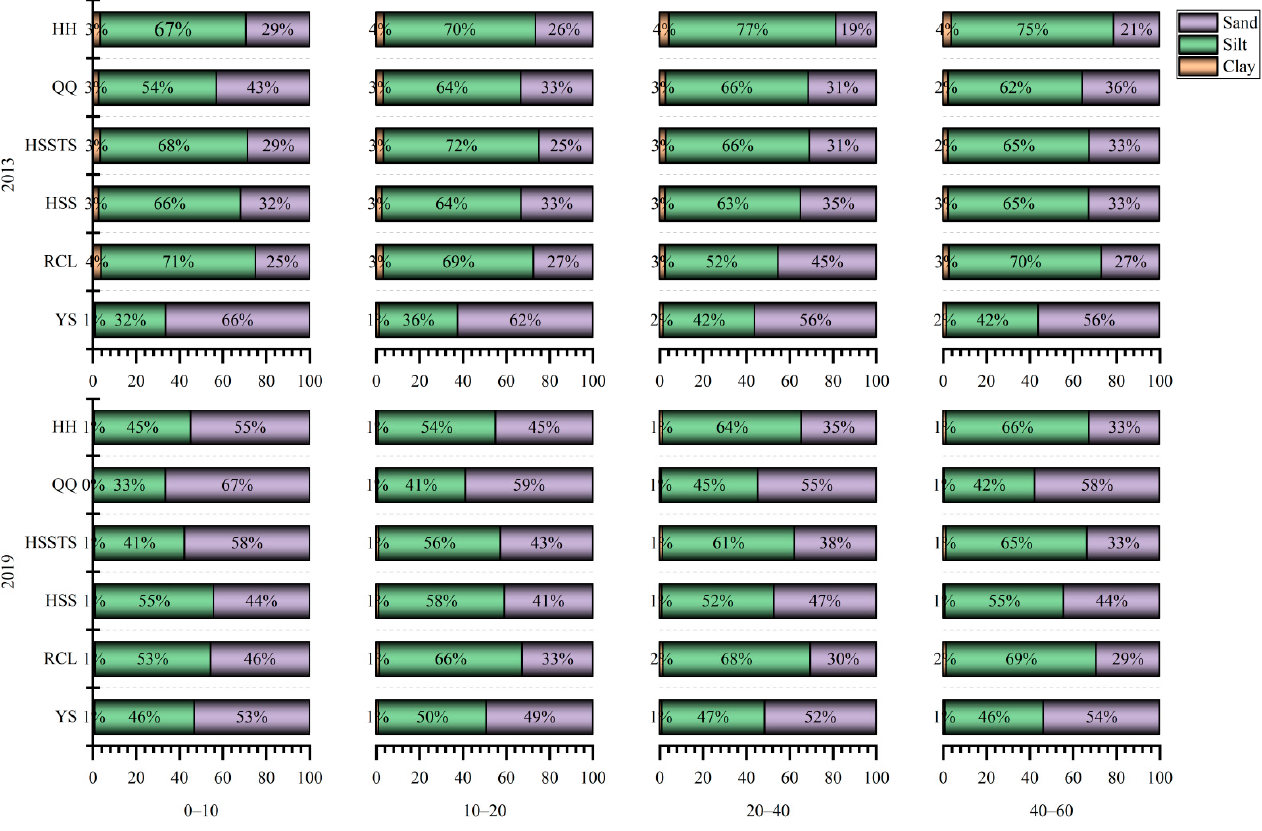
Figure 4. Physical properties of different forest communities at four soil depths in both 2013 and 2019; ( a ) soil pH, ( b ) soil porosity, ( c ) soil bulk density, ( d ) soil mechanical composition.